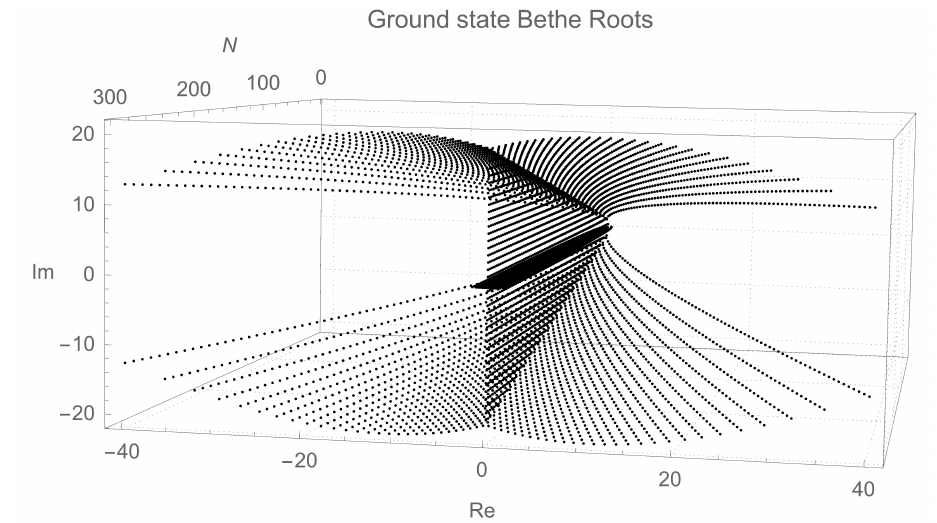
Figure 2: Inhomogeneous Bethe roots for N = 4 to N =